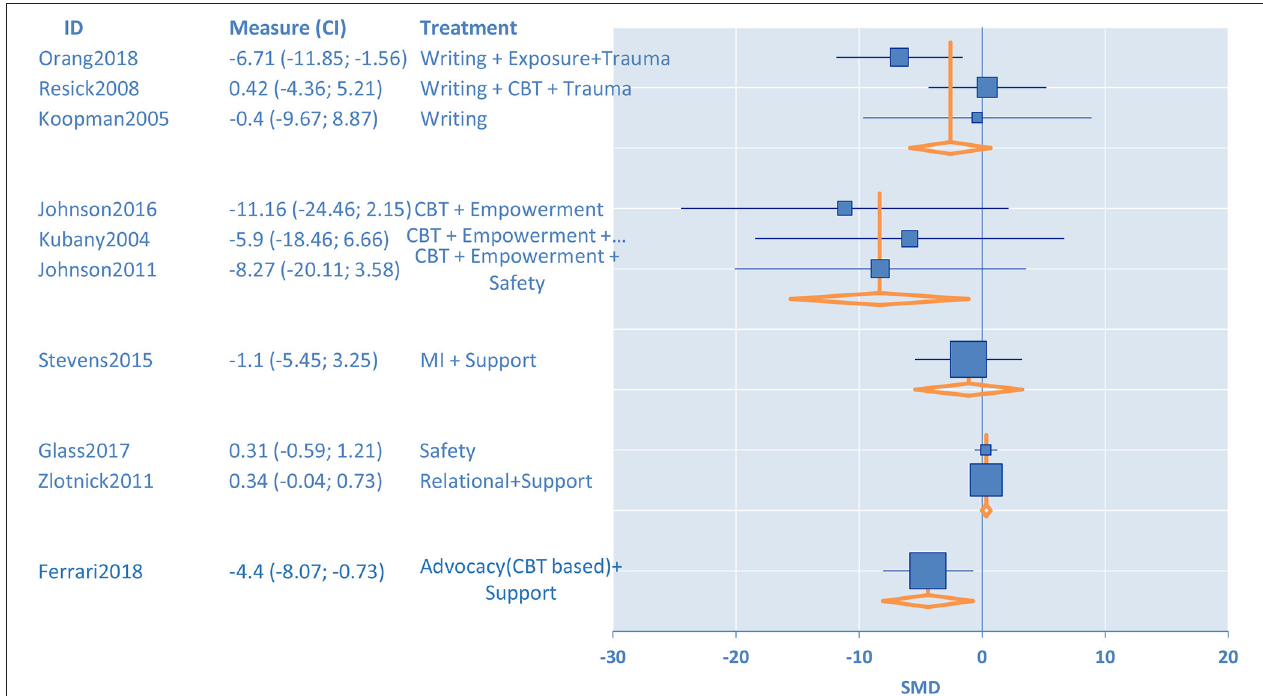
FIGURE 5 | Subgroup analysis for treatment of PTSD for female victims of intimate partner violence.